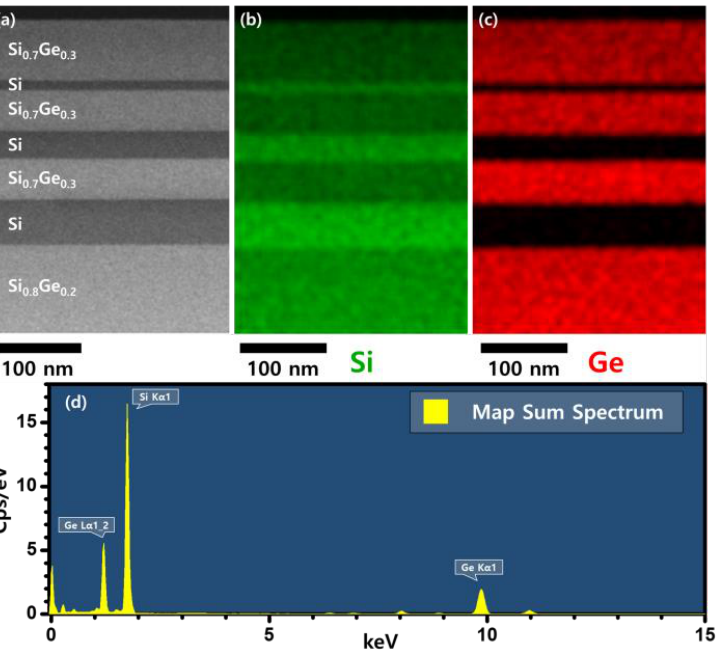
Figure 3. As-grown Si/Si 0.7 Ge 0.3 multi-layer: ( a ) TEM image, EDS mapping results of ( b ) Si and ( c ) Ge elements, ( d ) X-ray emission spectrum.